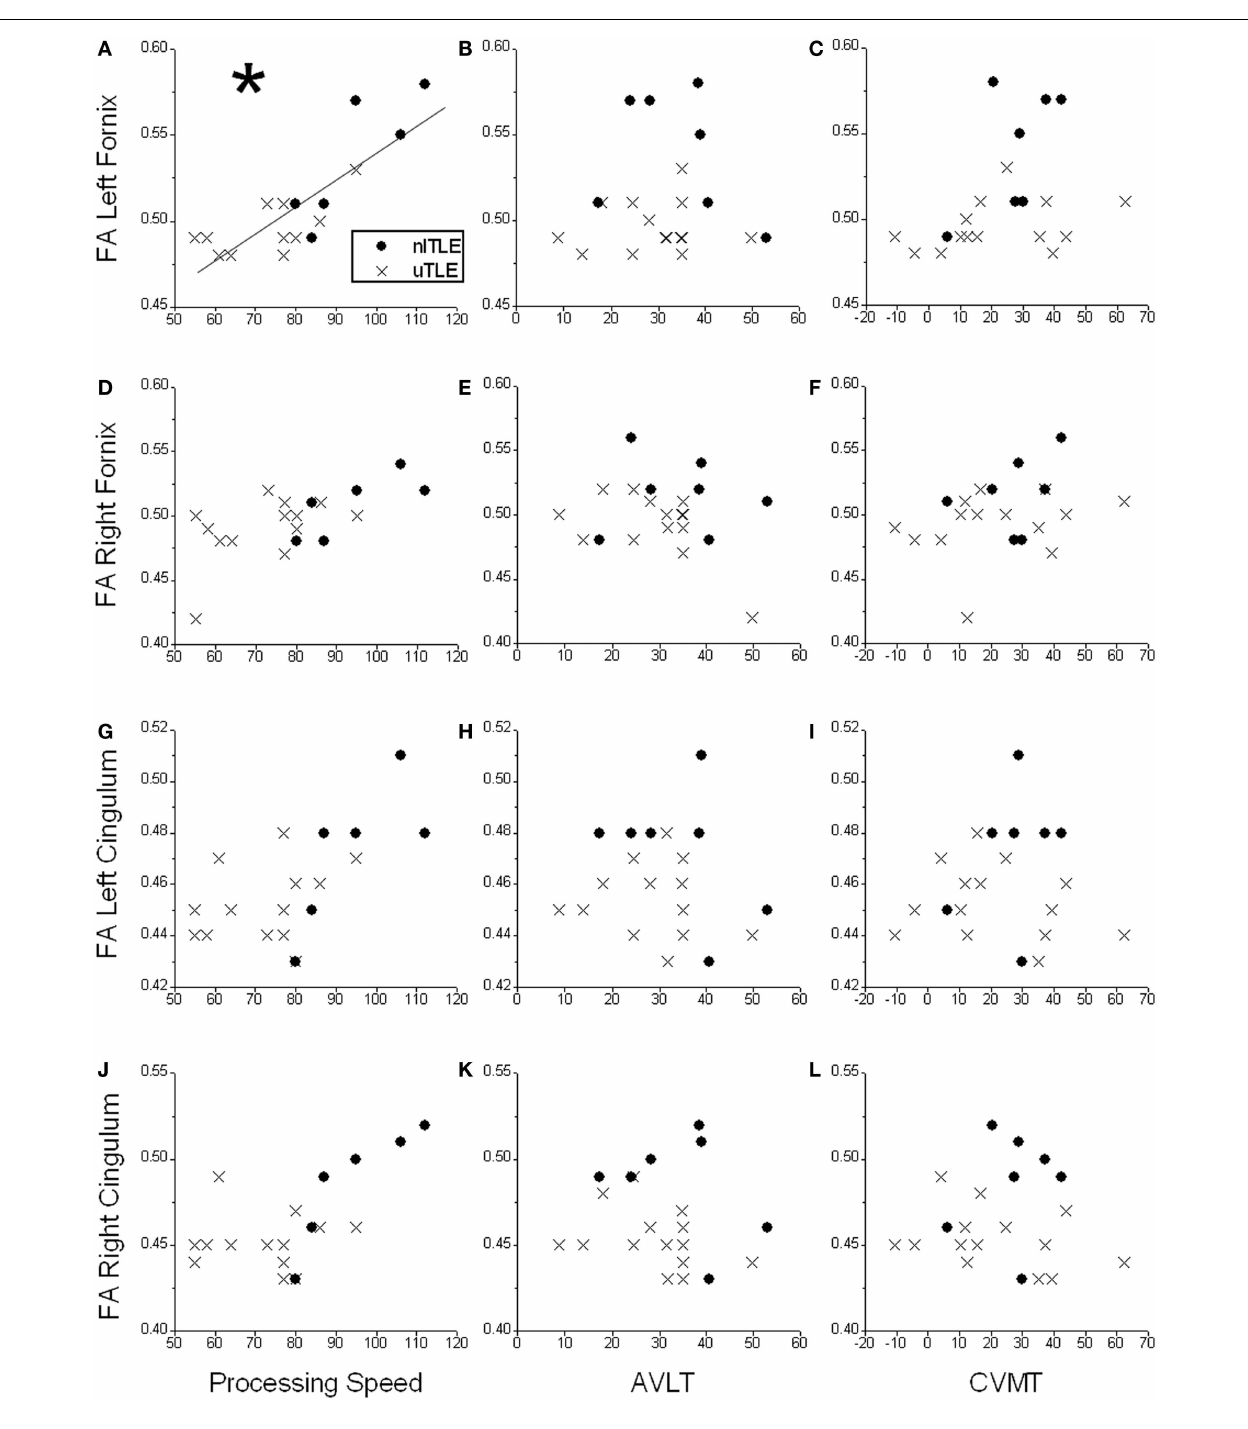
without mesial temporal sclerosis (nlTLE) and with mesial temporal sclerosis (uTLE) . *A significant positive correlation is seen between Processing Speed and FA of the left fornix which is primarily driven by the nlTLE subjects. No other significant correlations were observed for the other